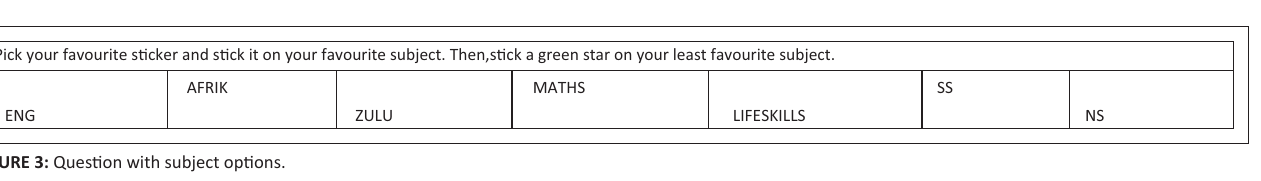
FIGURE 2: Question with subject options.